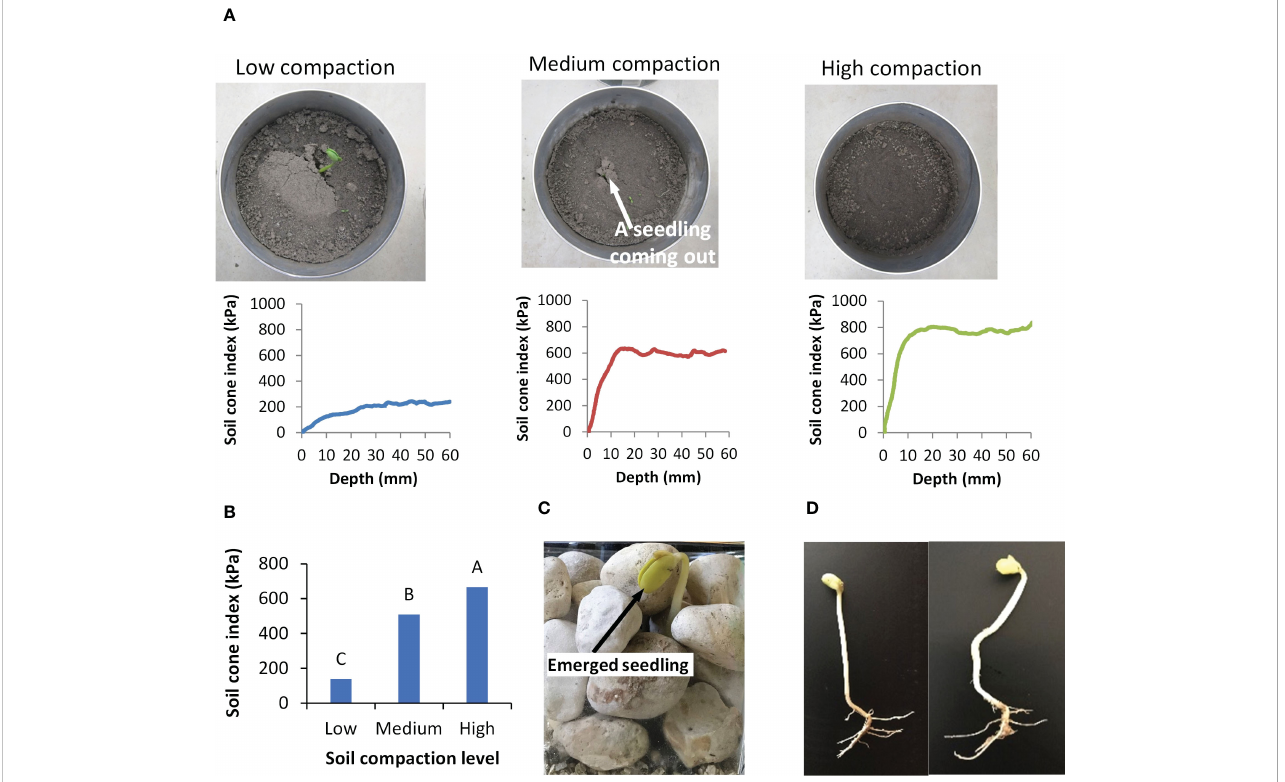
FIGURE 14 Effects of growth medium on seedling emergence. (A) Seedling emergence in soils with three different compaction levels and the corresponding soil cone indices measured using the micro-penetrometer. (B) Comparisons in average soil cone indices under different soil compactions; values labeled with different letters are statistically different according to Duncan ’ s Multiple Range Test at P<0.05; error bars stand for standard deviations. (C) Photo of a soybean seedling emerged from gravel. (D) A straight and a bent soybean seedling emerged from